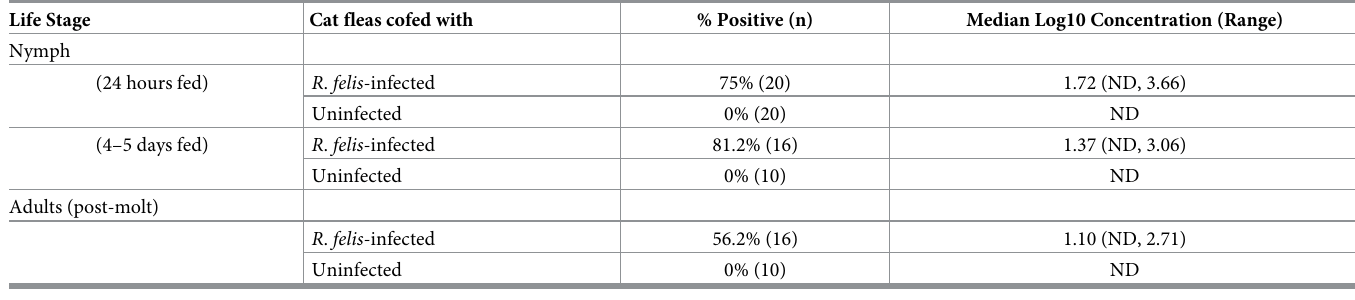
Table 1. Detection of rickettsiae by qPCR in D . variabilis nymphs cofed with uninfected or R . felis -infected cat fleas for 24 hours on a vertebrate host. Rickettsial infection was also assessed in ticks after completion of blood meal acquisition (4–5 days) and as newly molted adults. Life